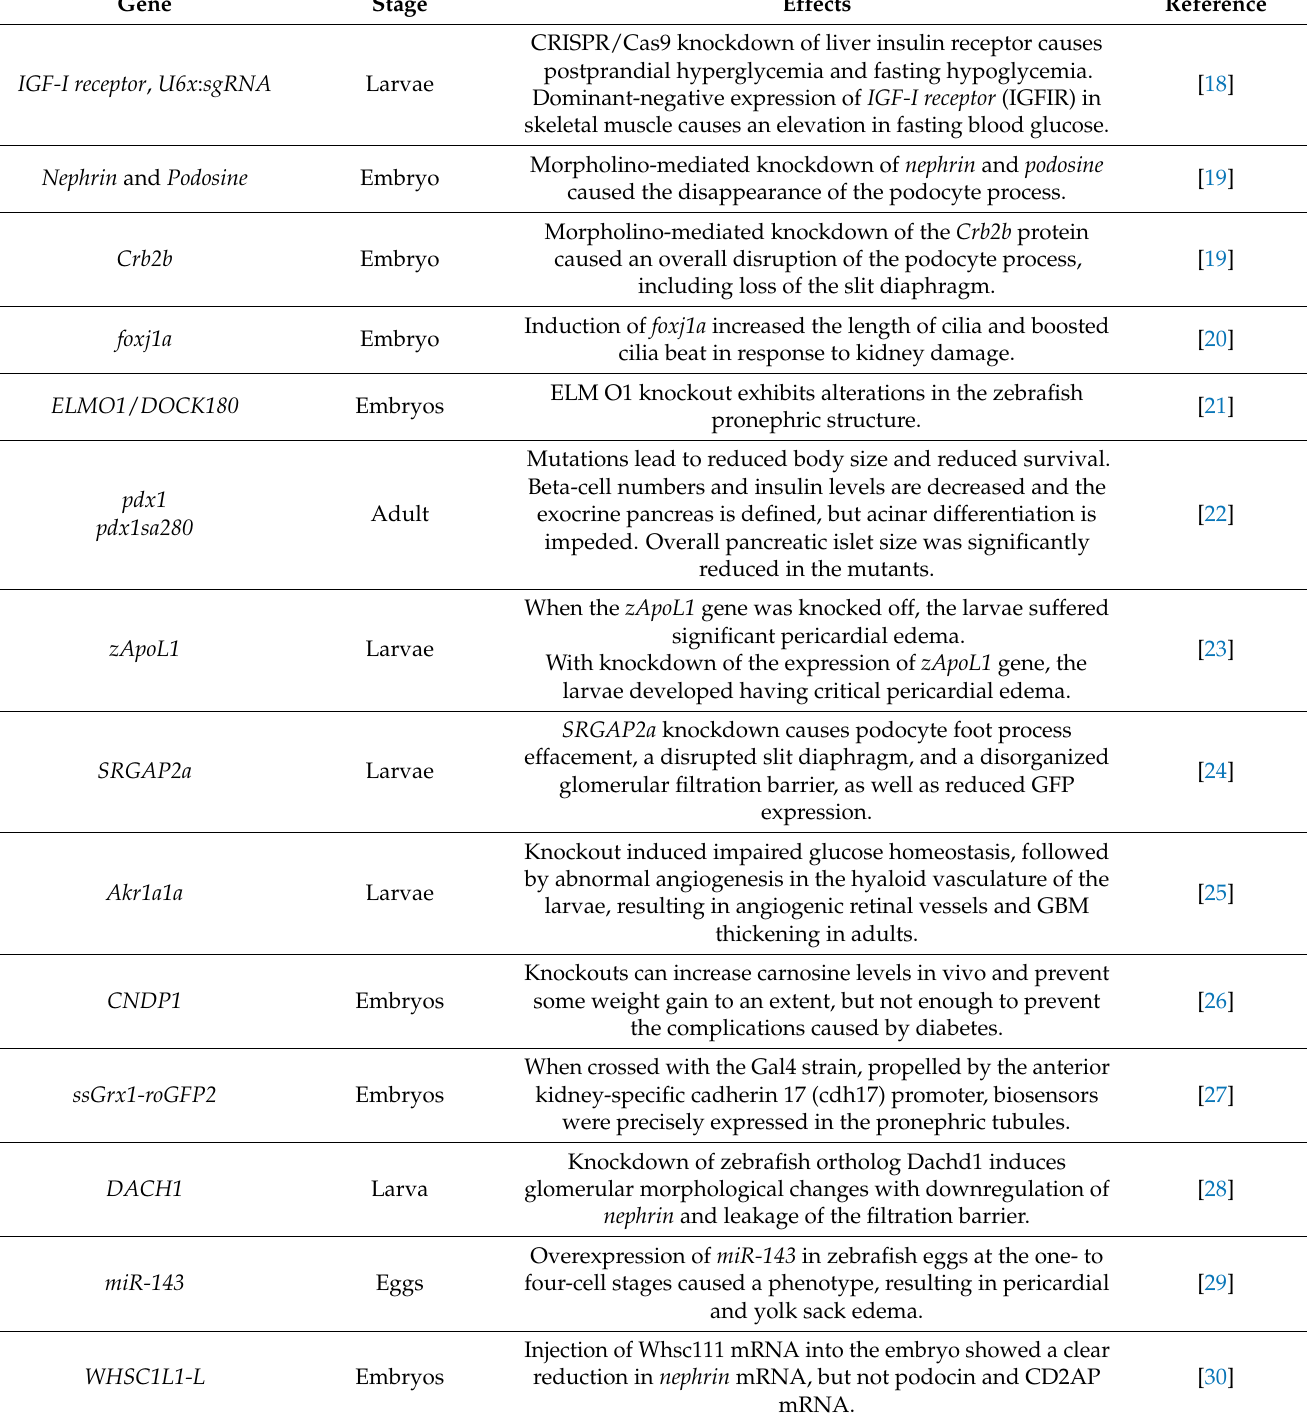
Table 1. Selected genes and experimental models of diabetic nephropathy in